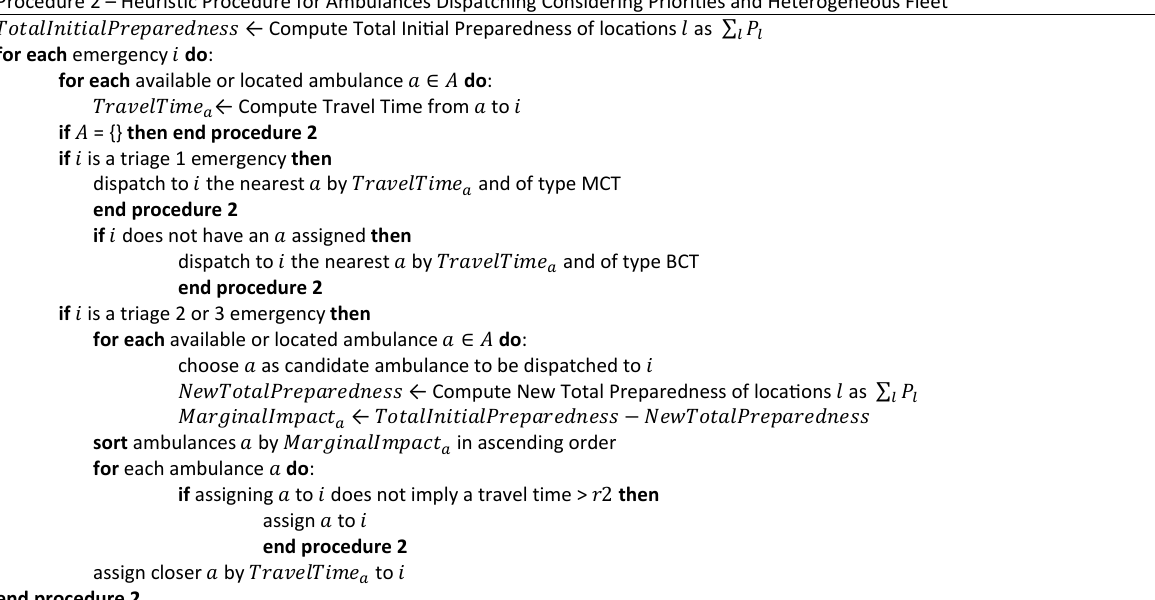
Procedure 2 – Heuristic Procedure for Ambulances Dispatching Considering Priorities and Heterogeneous Fleet